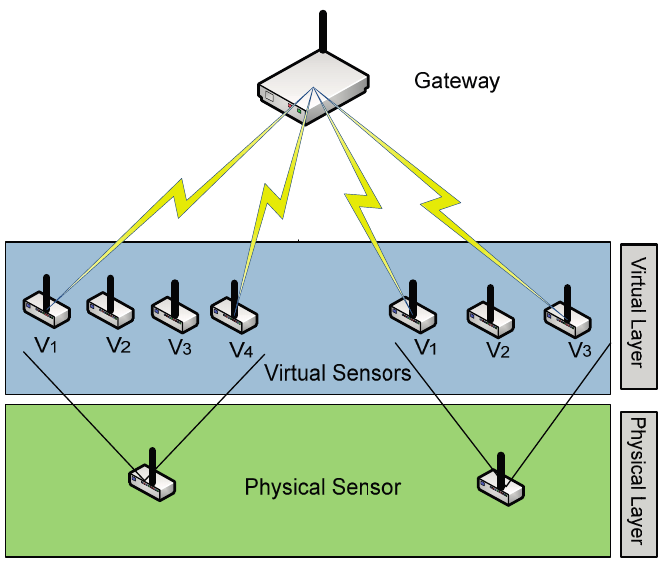
Figure 2. Sensor virtualization and virtual